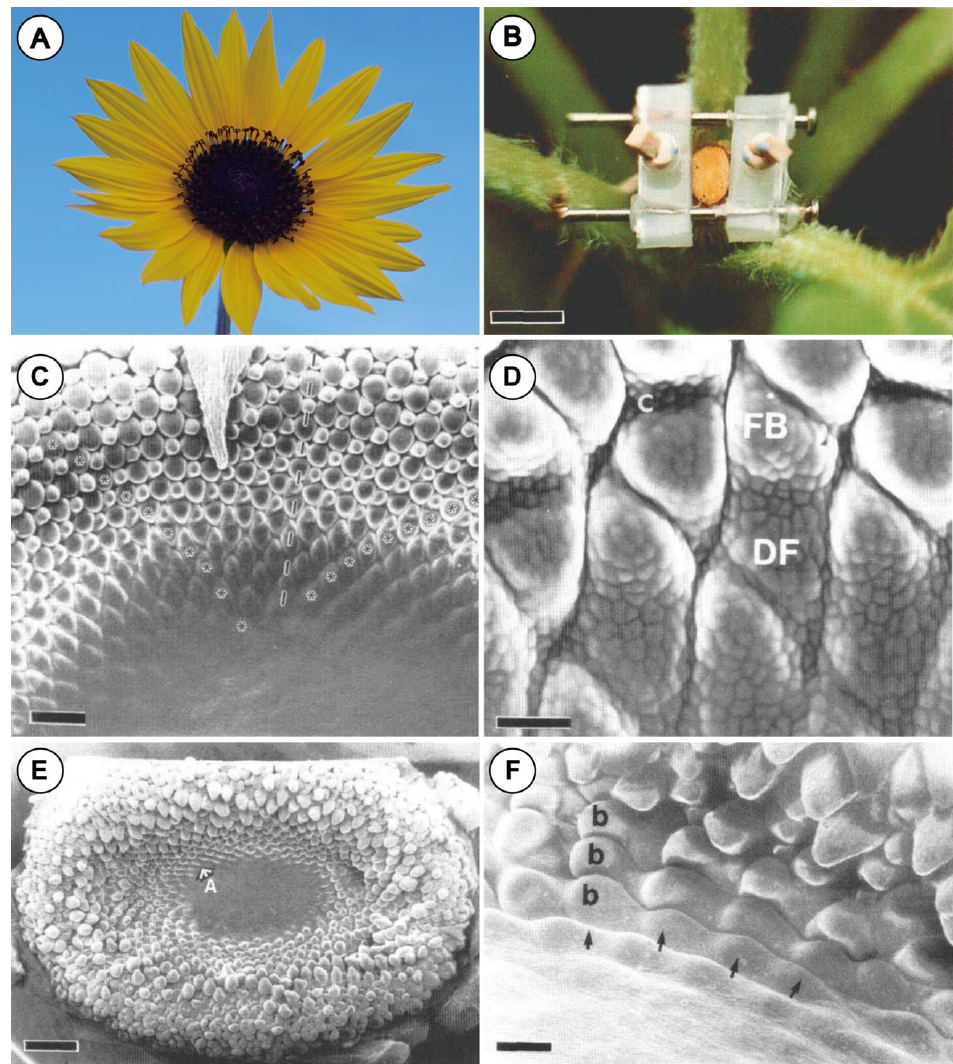
Figure 2. Experiments with mechanical pressures on developing meristems of Helianthus after Hern á ndez & Green (1993): ( A ) mature inflorescence of Helianthus annuus. ( B ) Inflorescence meristem is constrained with device. ( C ) Inflorescence meristem without compression forces by device. Generative zone is an arc-like region. Two spiral parastichies of floret primordia (asterisk) and radius of inflorescence (dashed line) are indicated. ( D ) Developing florets in ( C ). Upper portion of each floret becomes a disc flower bract (FB), and lower portion becomes a disc flower. A transverse crease develops in older florets. ( E ) Inflorescence meristem with 9 days compression by device. “A” denotes area shown in ( F ). ( F ) Developing florets denoted by “A” in ( E ). Floral primordia buckles, which are unusual in that they become single large bracts (b) rather than dyad florets shown in ( D ). Phyllotaxis in floral meristem is also distorted compared with that in a normal meristem in ( C ). Abbreviations: C, crease; DF, disc flower; GZ, generative zone. Scale bar in ( B ) = 5 mm; in ( C ) = 200 µ m; in ( D ) = 40 µ m; in ( E ) = 1 mm; in ( F ) = 100 µ m. (( B – F ) Reproduced from Hern á ndez and Green, 1993 with permission)